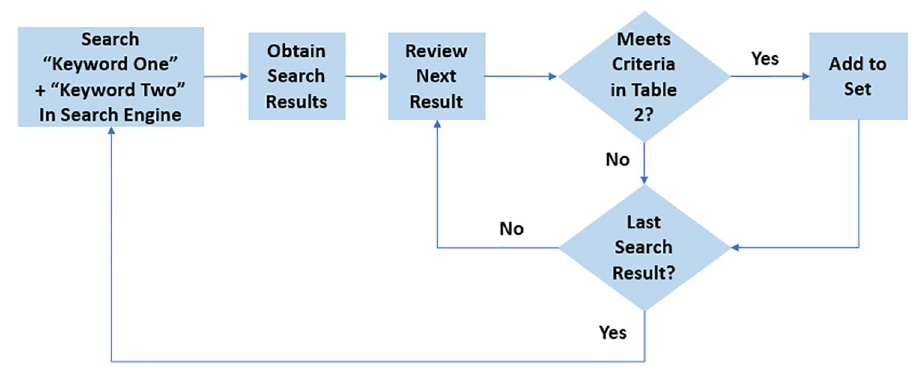
Fig 1. Heuristic process of data collection.